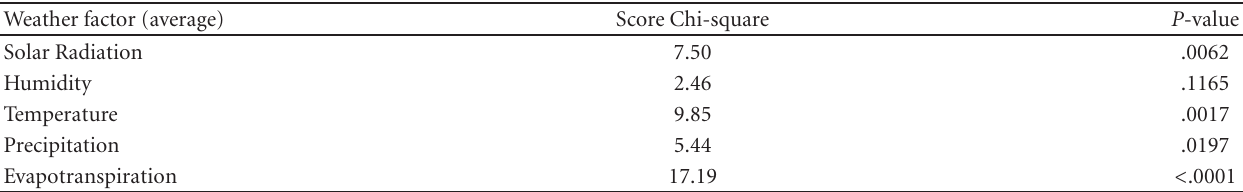
Table 5: Univariable analysis of the influence of each weather related variable on the hazard (survival) of M. bovis in the environmental using the score test in Cox regression.